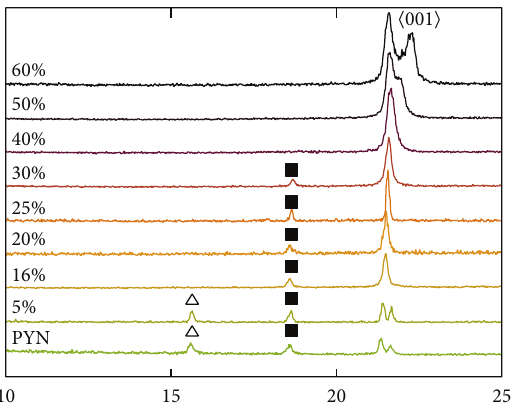
Figure 6: X-ray diagrams for PYN-PT ceramics obtained by mechanosynthesis for PbTiO 3 content between 0 (PYN) and 60%. Squares ( ◼ ) indicate superstructure reflections due to chemical order on the B site. Triangles ( △ ) mark superstructures due to antiparallel displacements. All samples were sintered between 950 ∘ C and 1050 ∘